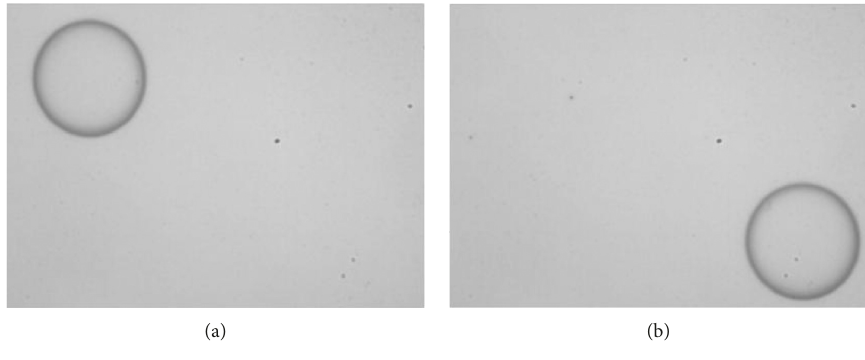
Figure 9: Outermost PSs used for training.